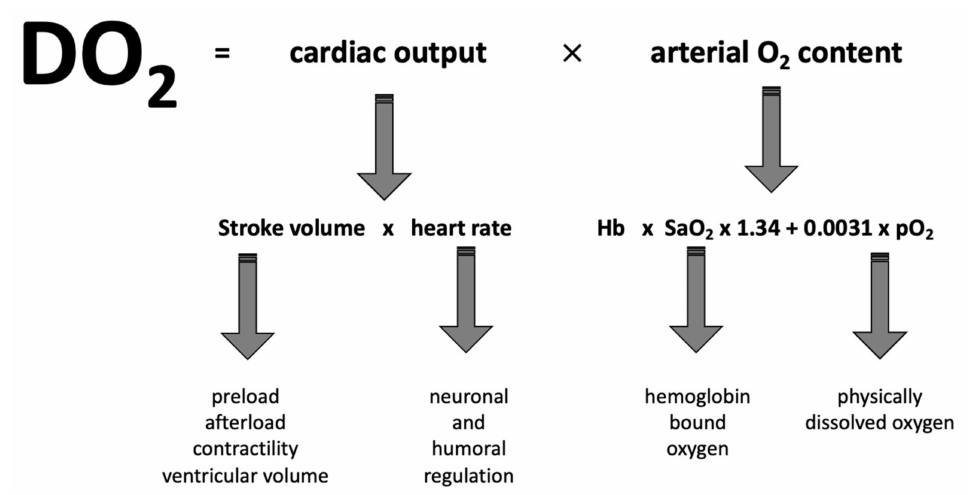
Figure 1. Oxygen delivery (DO 2 ) is defined as the product of cardiac output and arterial oxygen content (CaO 2 ). Cardiac output is defined as the product of stroke volume and heart rate. Stroke volume depends on preload, afterload, contractility, and ventricular volume, whereby neuronal and humoral factors modulate heart rate. Arterial oxygen content is defined as the sum of hemoglobin- bound oxygen (hemoglobin concentration times arterial saturation times Hüfner’s number) and physically dissolved oxygen (arterial oxygen partial pressure times a